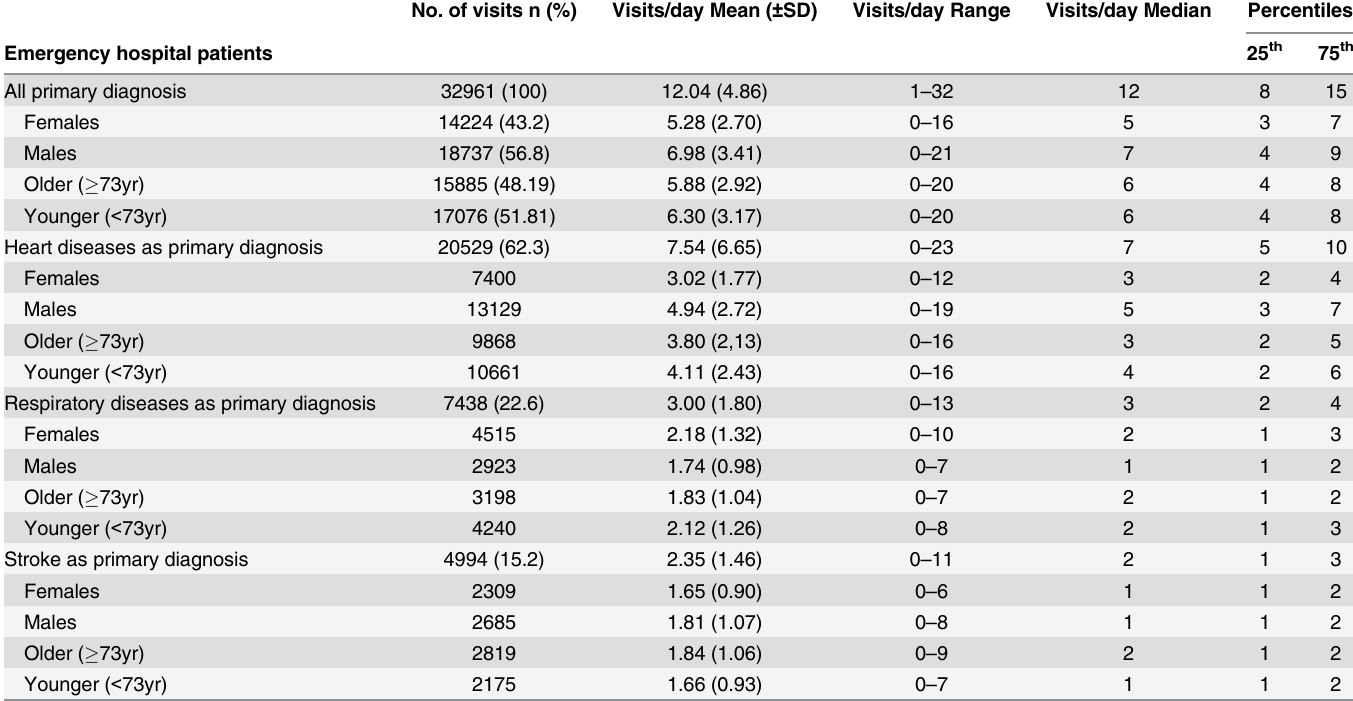
Table 1. Descriptive statistics of daily emergency hospital visits to Landspitali University Hospital, according to primary diagnosis, during 1 Janu- ary, 2007 to 30 June, 2014.